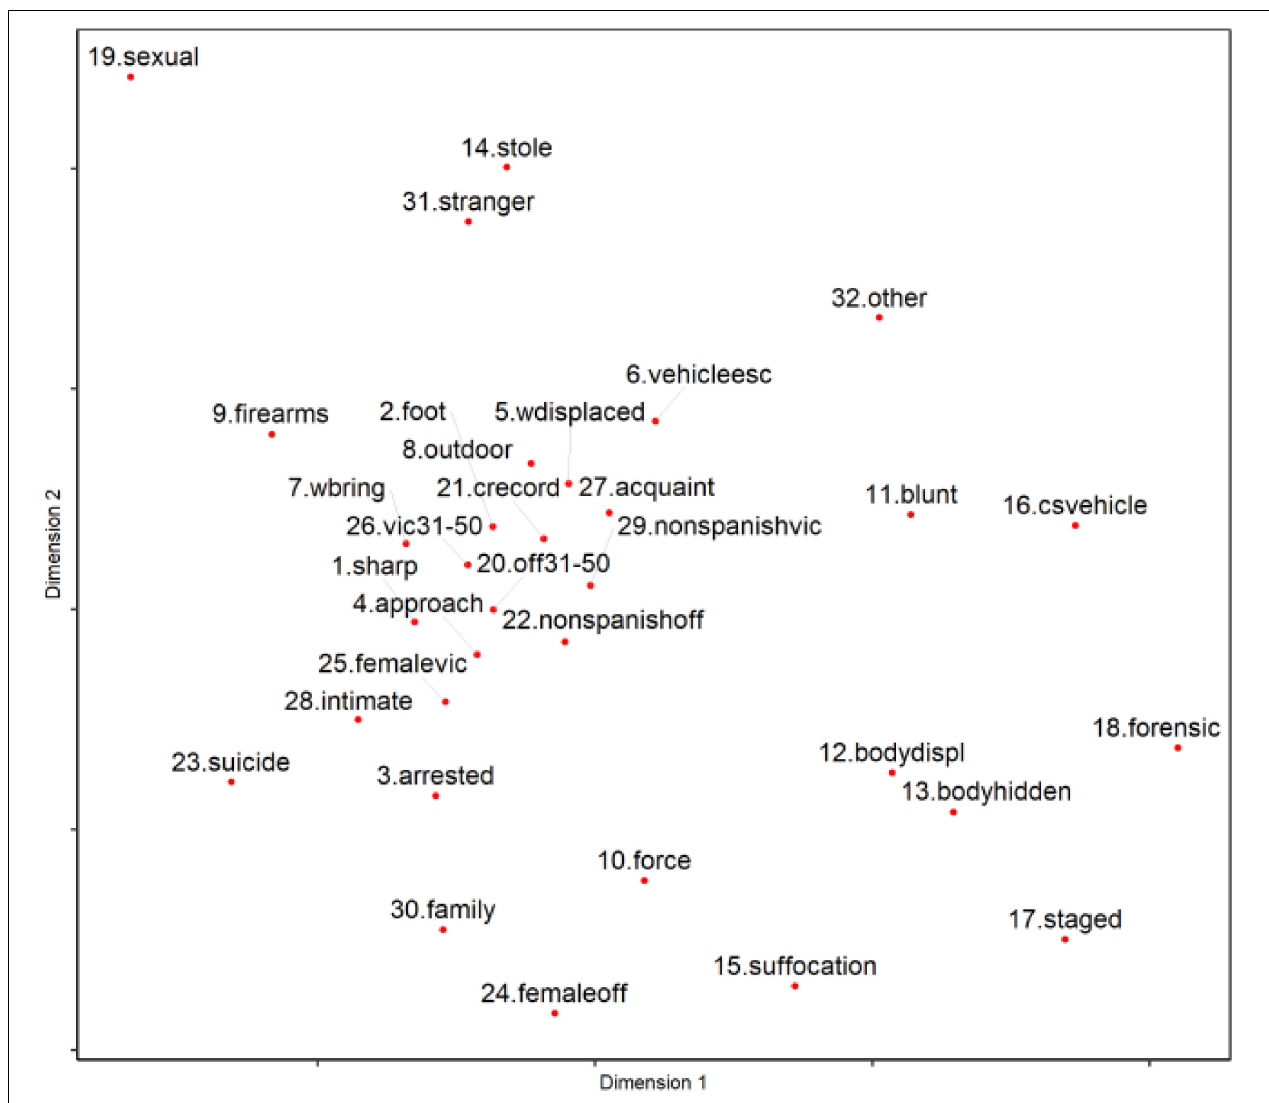
FIGURE 1 | Bi-dimensional map of the